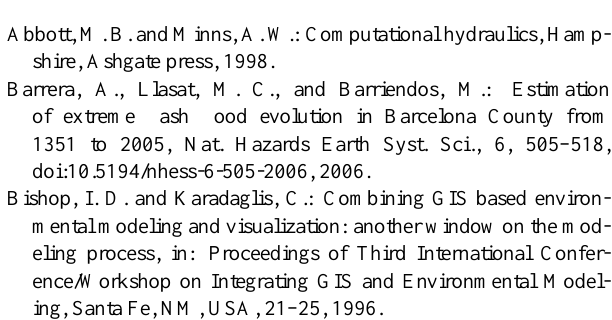
Table 1. Comparison between computed and observed peak inundation depth in calculation area